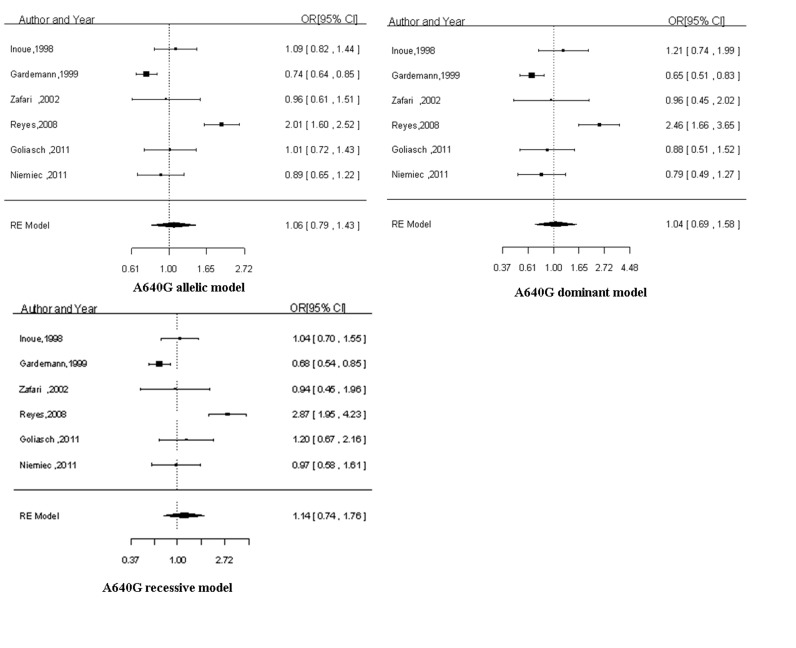
The forest plots of OR with 95% CI for A640G polymorphism and CAD risk.OR, Odds ratio; 95% CI, 95% confidence interval; RE, random-effects model; FE, fix-effects model; CAD, coronary artery disease.